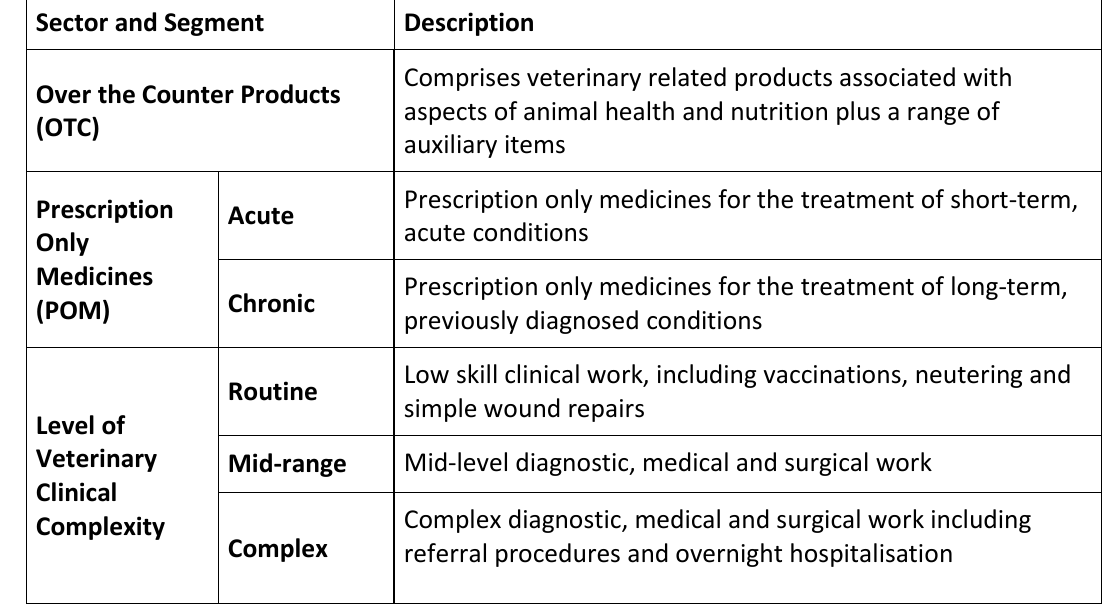
Figure 2. Small Animal Sector market segments Over the Counter Products